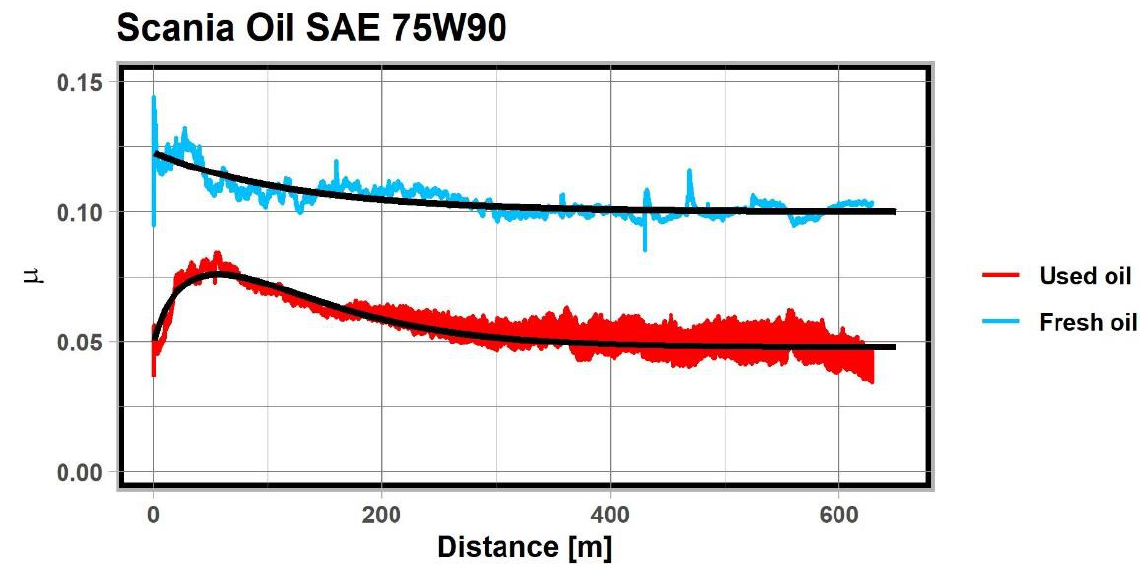
Figure 4. The curve of the friction coefficient depending on the friction path for oil SAE 75W-90 and fitting Function (1).